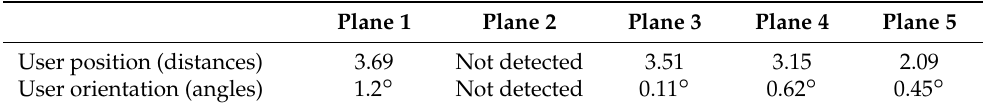
Table 4. Validation of the user position based on distance measurements (m) and the user orientation based on the alignment between virtual and scanned plane in a nonideal